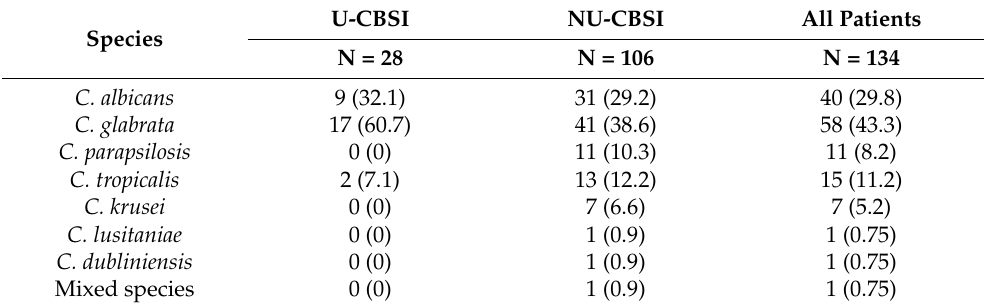
Table 2. Candida species distribution among urinary and non-urinary candidemia episodes.